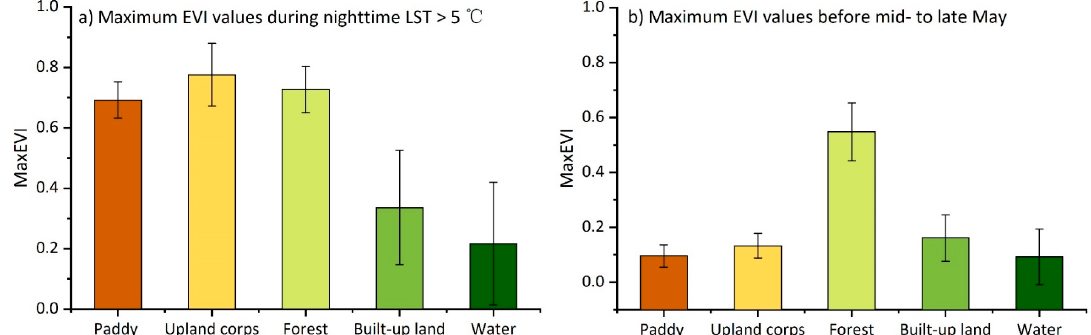
Figure 10. Threshold selection for mask, ( a ) sparse vegetation mask, and the curves shows the maximum EVI values of di ff erent land covers during nighttime LST > 5 ◦ C, ( b ) natural vegetation mask, and the curve shows the maximum values of di ff erent land cover types before mid-to late May.